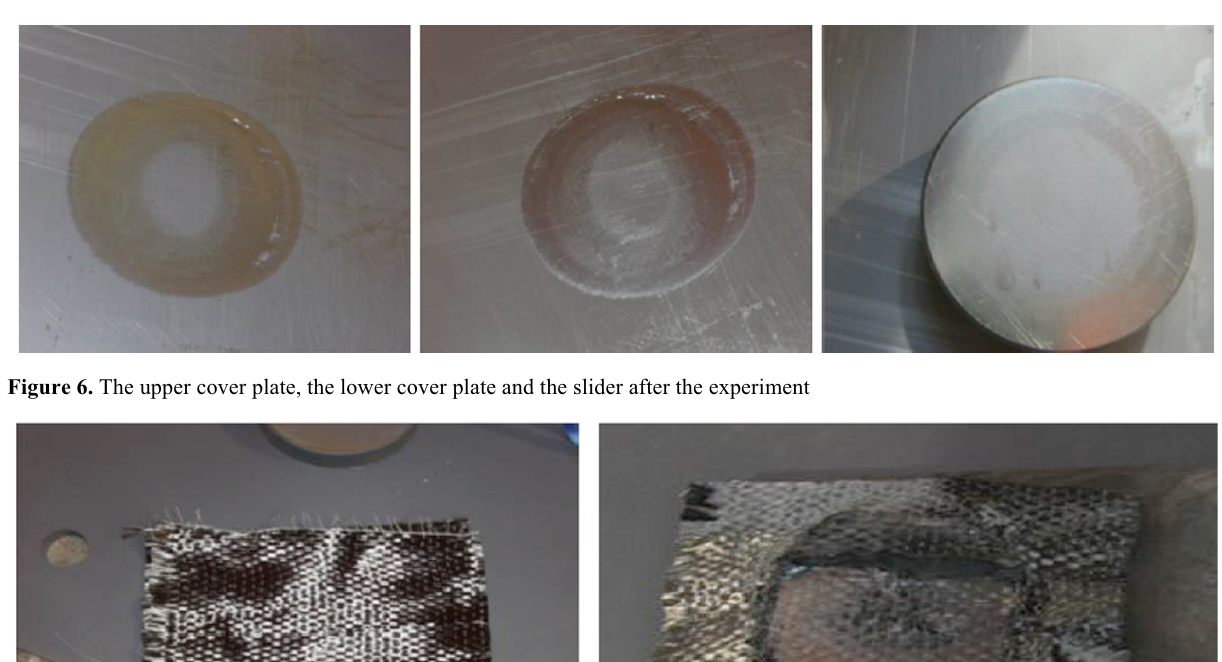
conditions. But the third group had a terrible tearing as shown in Fig.7.